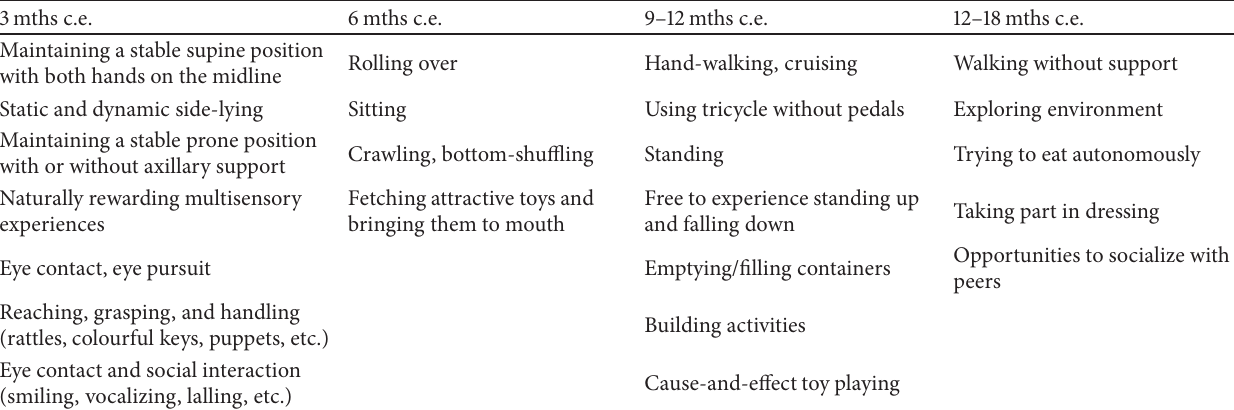
Table 1: Training, differentiated by corrected age, of postural control, motor, and play activities, and environmental interactive skills. 3mths c.e.